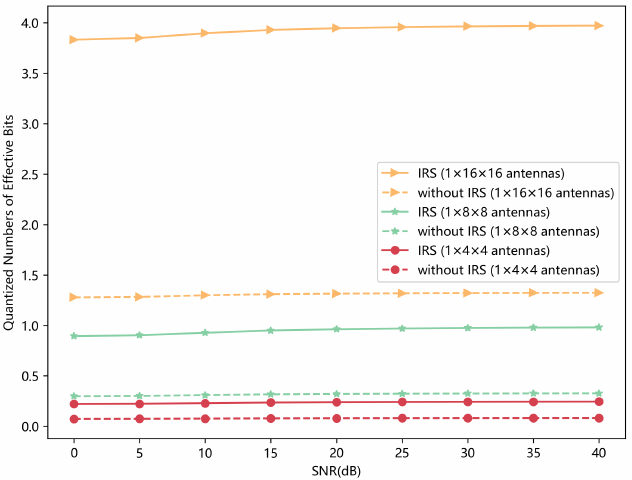
Figure 10. Quantized numbers of effective bits that initial keys have with different IRS parameters versus SNR. The scenario with an IRS having 1 × 8 × 8 antennas is treated as a benchmark. Note that δ is set to 0.01.